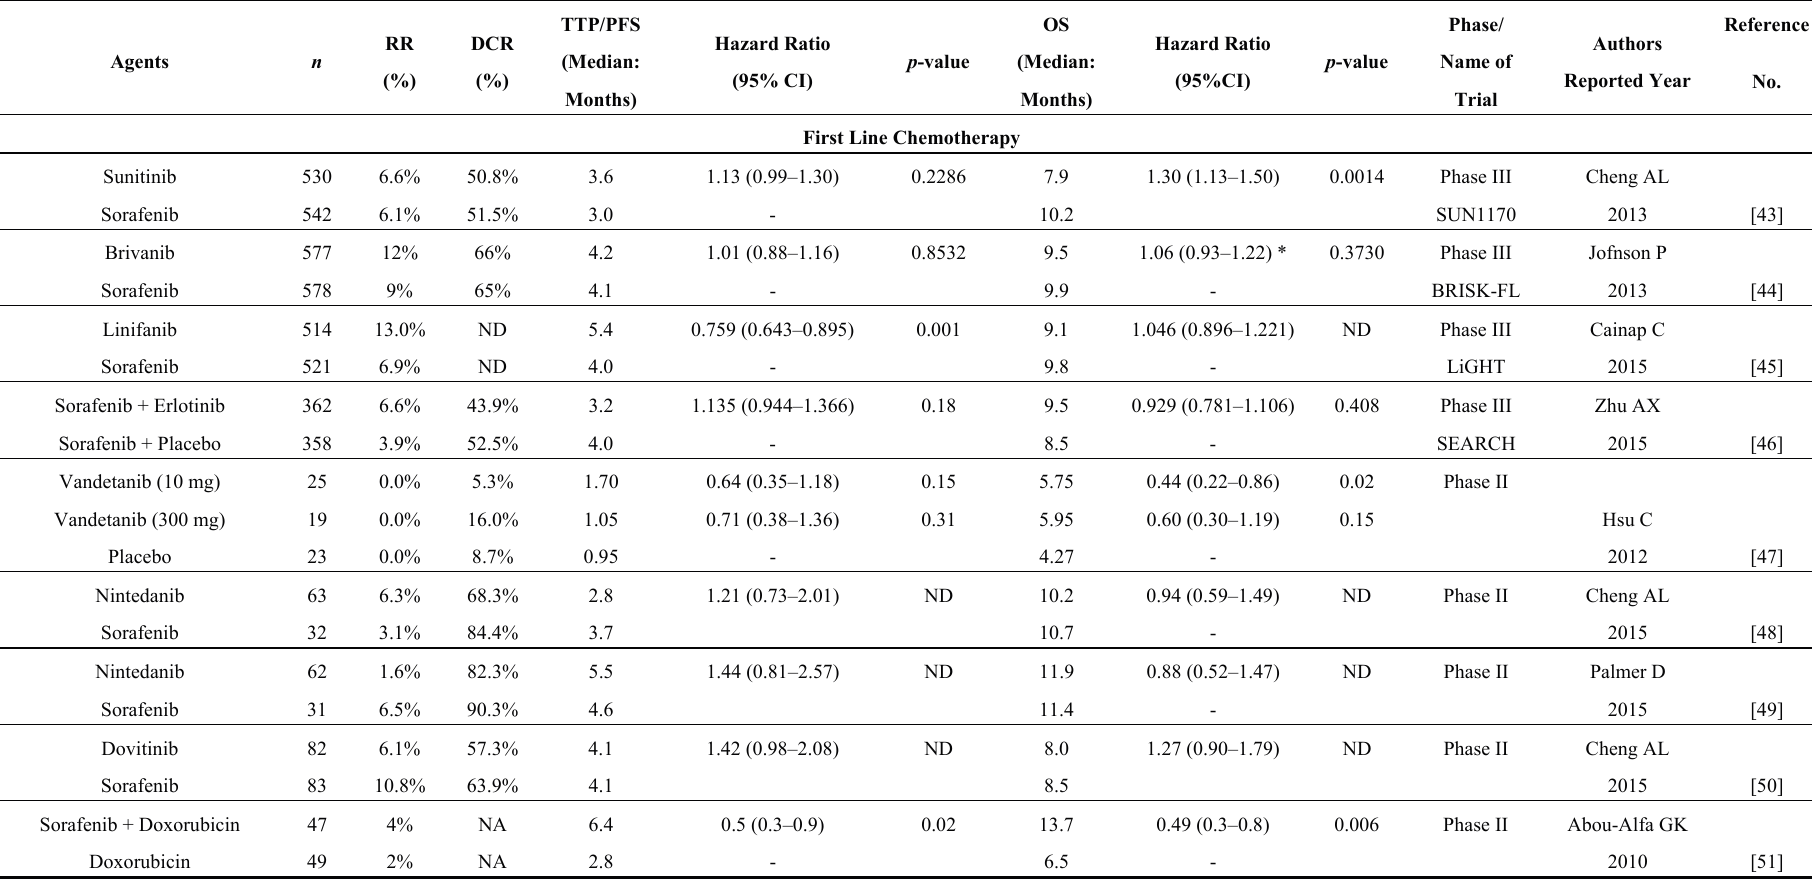
Table 2. Results of main randomized controlled trials worldwide as first-line and second-line treatment for patients with advanced HCC: